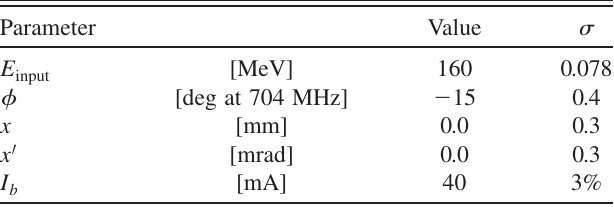
TABLE V. Beam input parameters and assumed variation based on Linac4 beam dynamics simulations and SNS data for the bunch charge scatter.